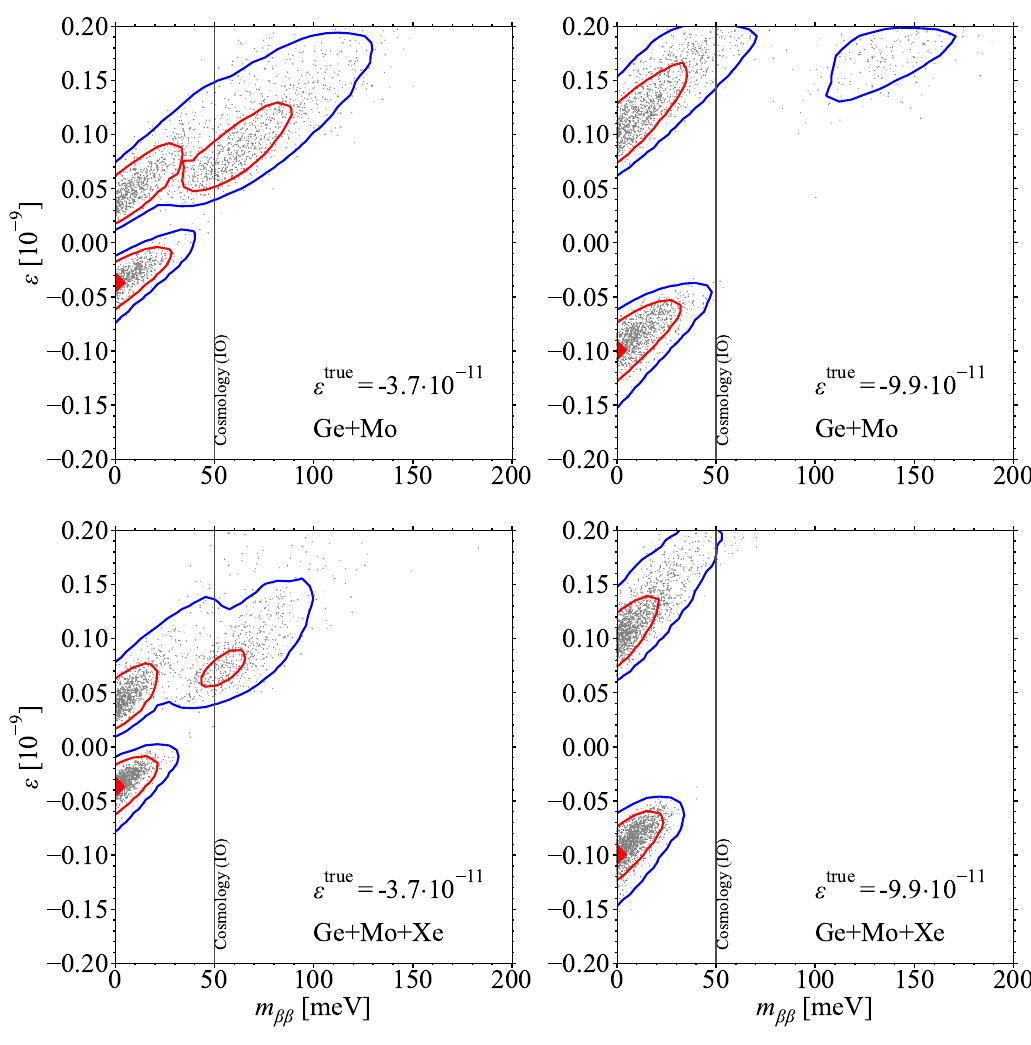
Figure 8 . Bayesian posterior probability distributions and credible regions, with current NME un- certainties, for half-life values corresponding to (cid:15) = − 3 . 68 · 10 − 11 (left column) and (cid:15) = − 9 . 94 · 10 − 11 (right column), for isotopes Ge+Mo (top row) and Ge+Mo+Xe (bottom row). 68% and 95% prob- ability credible regions are plotted in red and blue, respectively. The present cosmology bound on m ββ from the inverted neutrino mass ordering (IO), described in the text, is plotted as a vertical